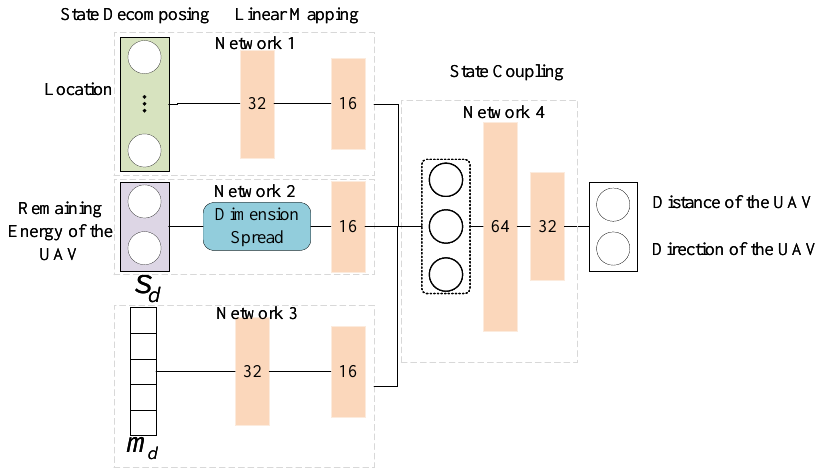
Figure 5. The network architecture of the actor in the UAFC